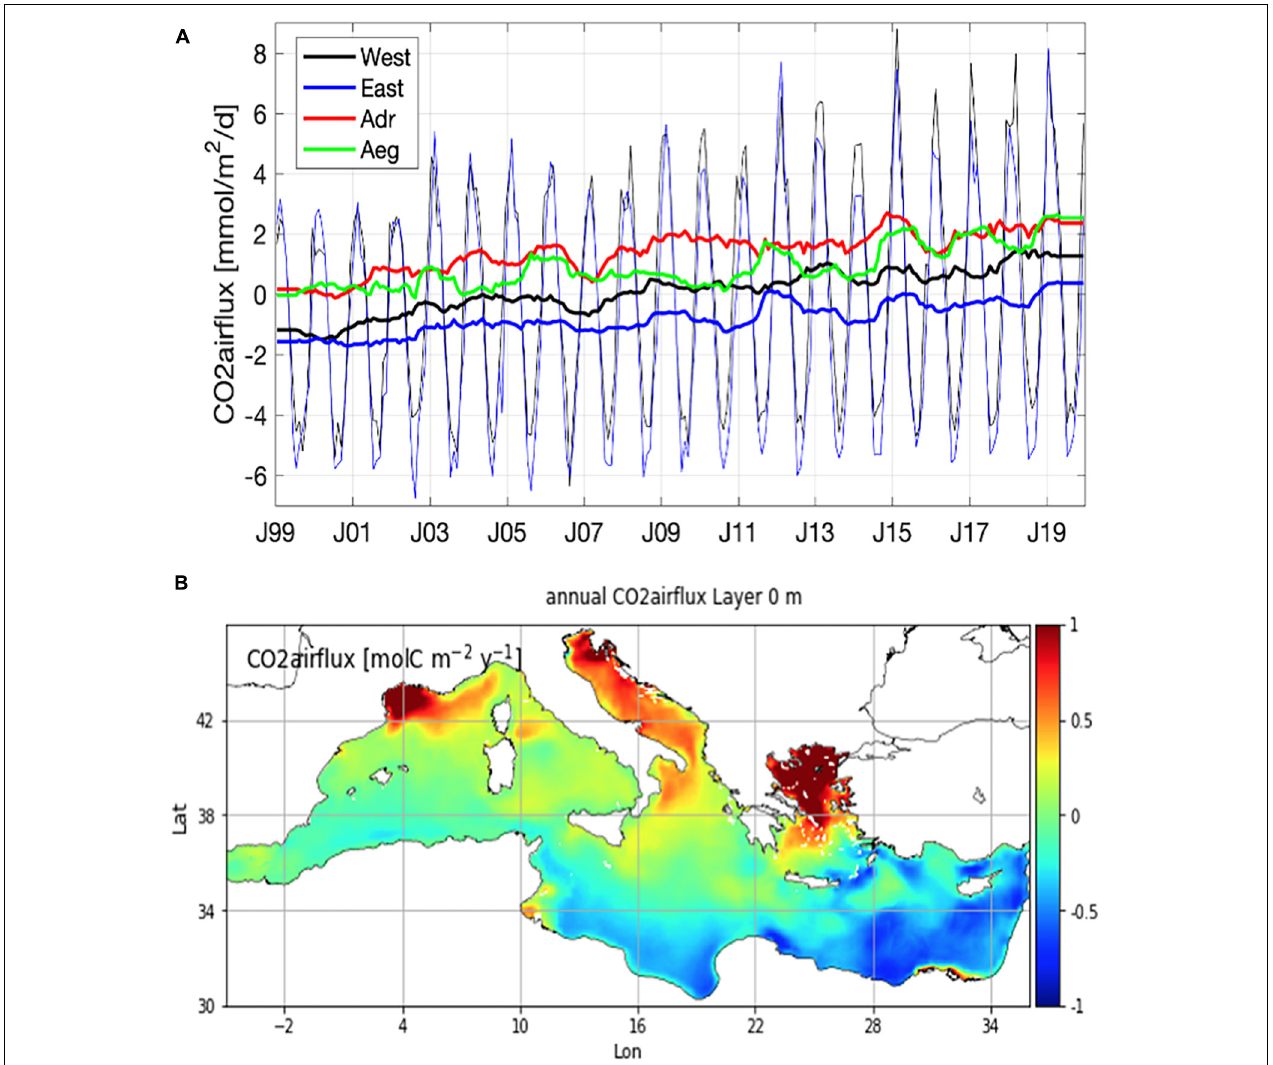
FIGURE 11 | Monthly time evolution (thin lines) and its moving average (thick lines) of CO 2 air-sea flux (A) in the western and eastern Mediterranean Sea, Adriatic and Aegean Seas. Map of the mean annual CO 2 air-sea flux (B) . Positive values indicate sink of atmospheric CO 2